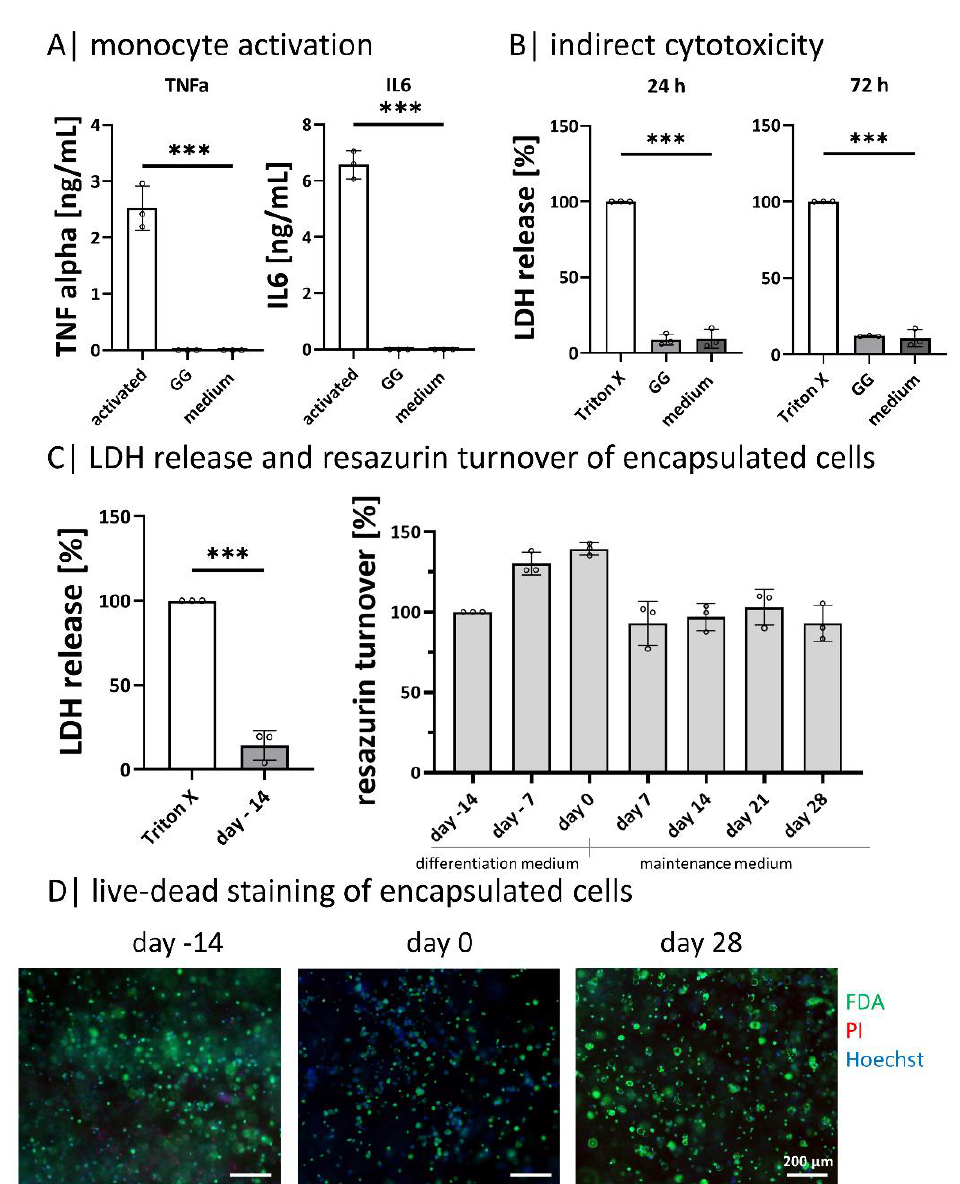
Figure 2. Cell-material interaction: ( A ) tracking of monocyte activation by the secretion of TNFα and IL6 after incubation in hydrogel supernatant, n = 3; ( B ) indirect cytotoxicity testing according to DIN EN ISO 10993-5 after 24 h and 72 h, n = 3; ( C ) diffASC resazurin turnover in GG-hydrogels over 42 days and LDH release after 24 h post-ASC encapsulation, n = 4; ( D ) live-dead staining of diffASC GG-hydrogels on days − 14, 0, and 28, viable cells in green, dead cells in red, and nuclei in blue. Scale bar 100 µM, n = 5. ◦ sample values, *** p ≤ 0.001.